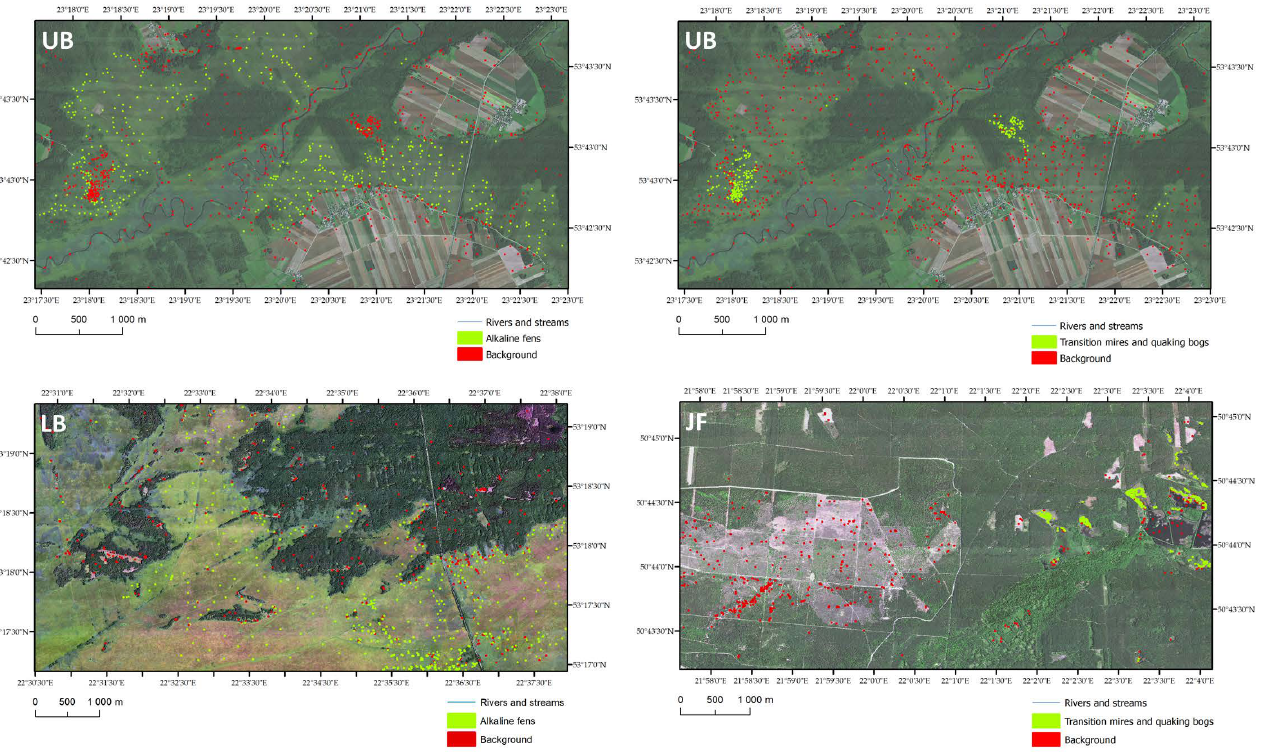
Figure 2. Location of reference botanical data for each wetland habitat in the Upper Biebrza (UB: Alkaline fens— upper left , and transition mires and quaking bogs— upper right ), the Lower Biebrza (LB: Alkaline fens— lower left ) and the Janowskie Forest (JF: Transition mires and quaking bogs— lower right